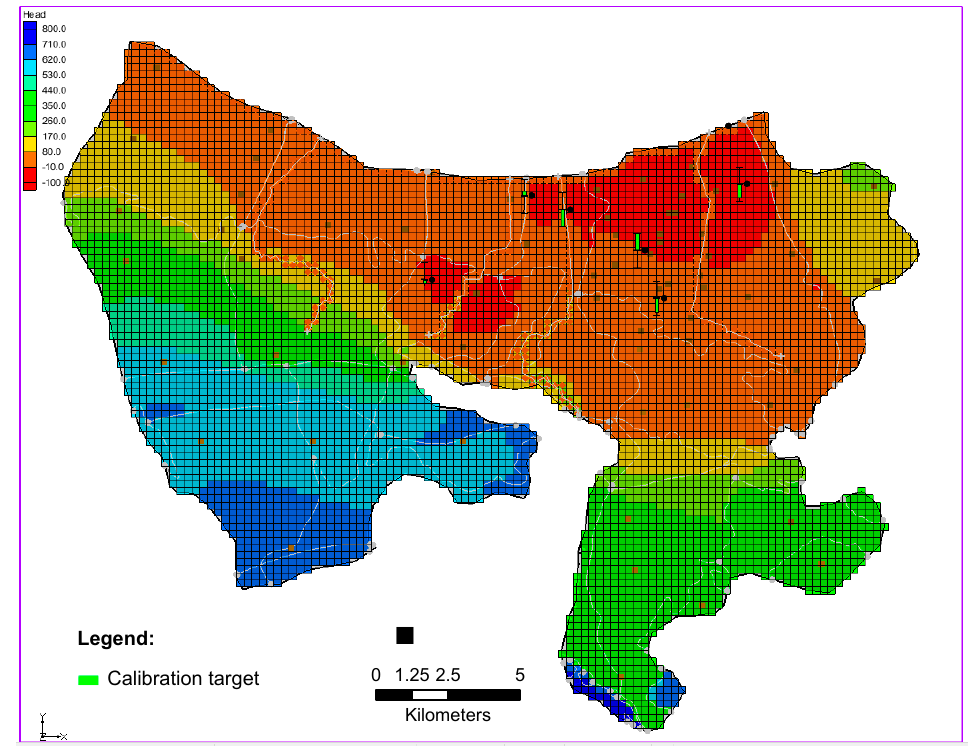
Figure 6. Results of the steady-state flow simulation.